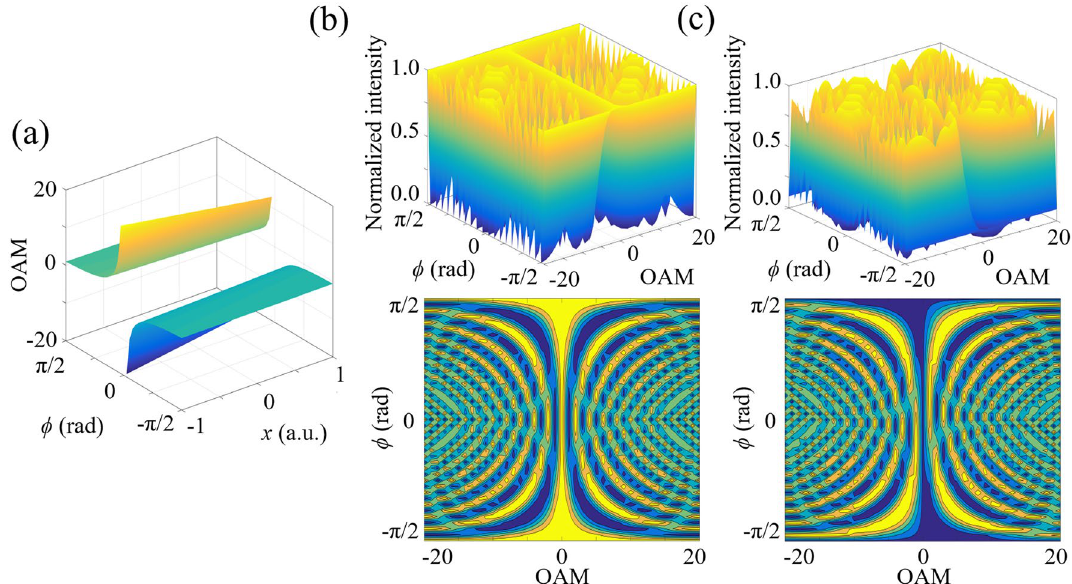
Figure 4. ( a ) OAM detection by means of geometric-phase-based shearing interferometry. ( b ) Simulated result of light intensity variation along the azimuthal direction in terms of various OAM states. With the change of the topological charge, an OAM-dependent displacement of interference fringes is induced along the azimuthal direction. ( c ) Changing behaviors of light intensities along x -axis become asymmetric for m > 0 and m < 0, which is applied to determine the sign of OAM